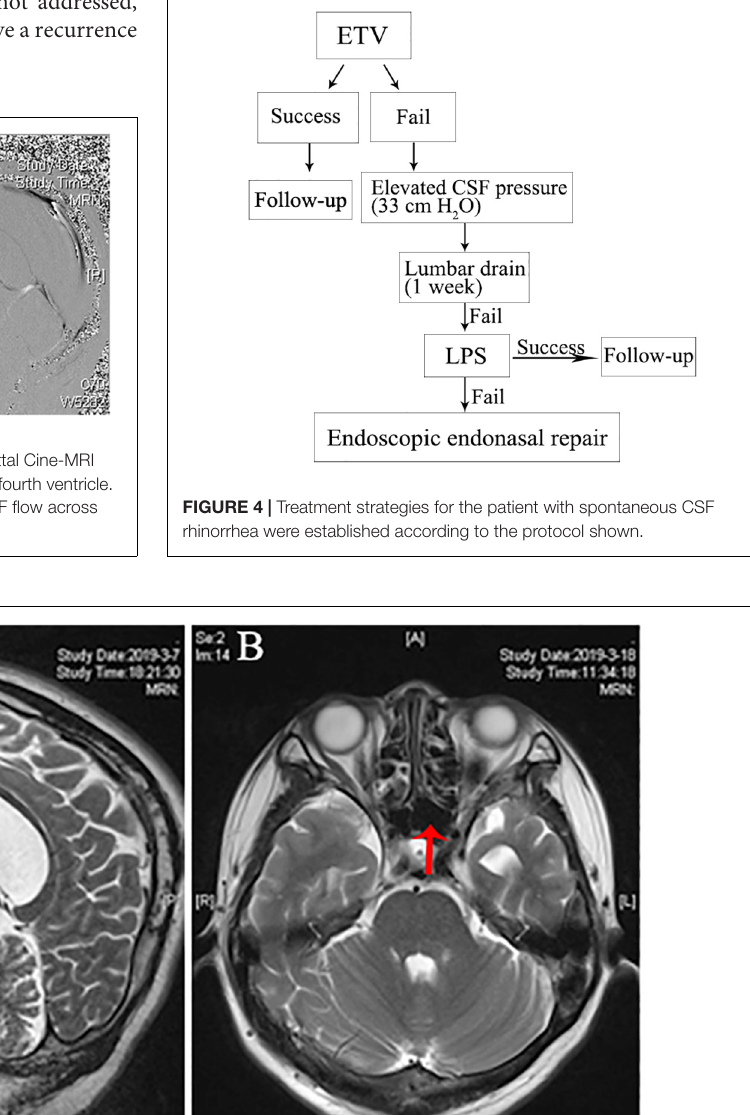
Frontiers in Neuroscience |